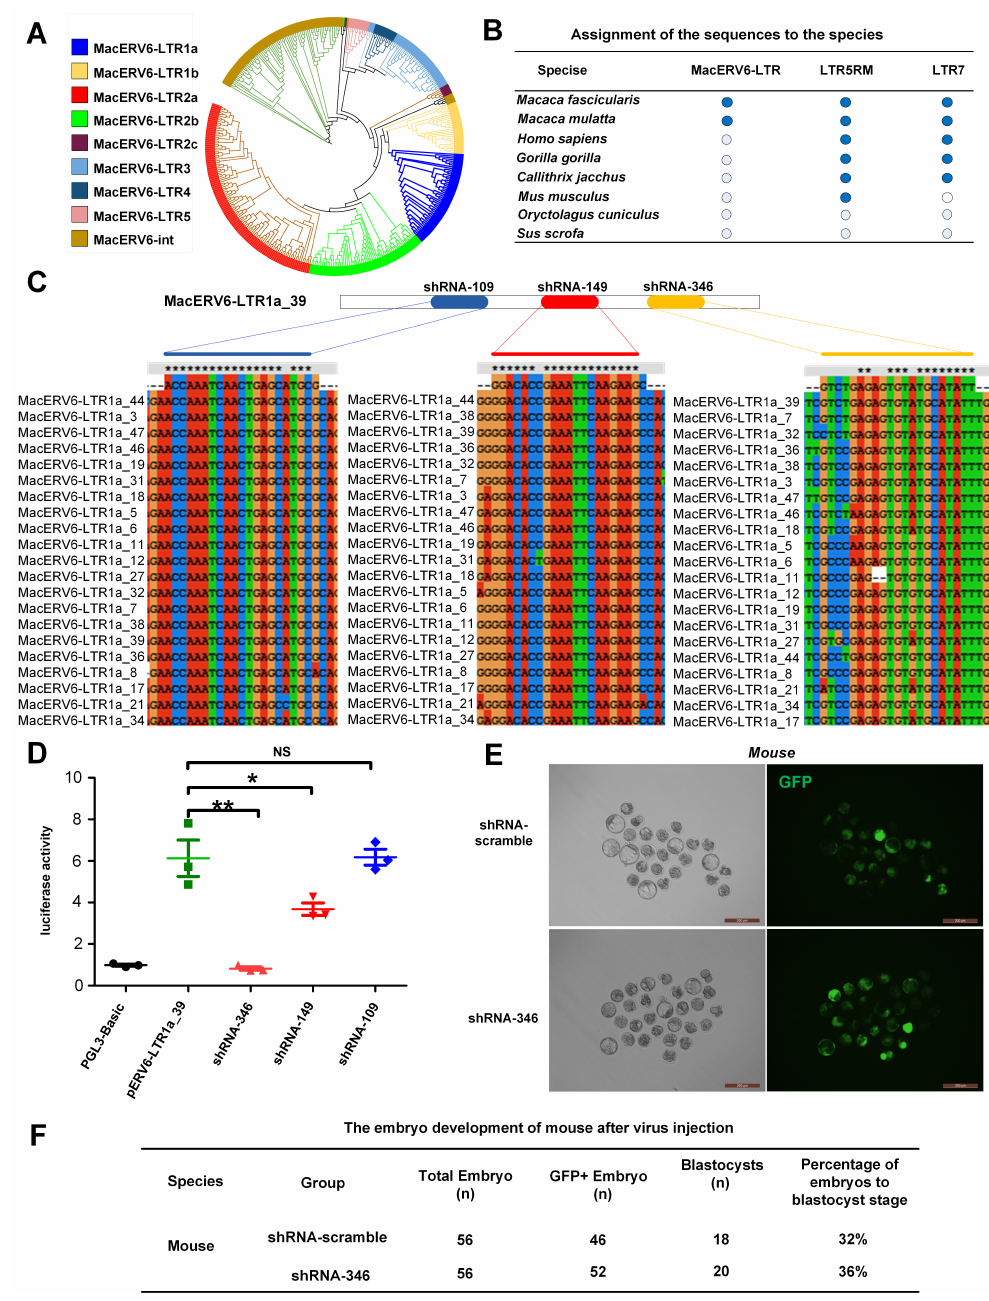
Figure 2. MacERV6-LTR1a knockdown in pre-implantation monkey embryos. ( A ) Phylogenetic tree based on the MacERV6 family sequences. ( B ) The conservation of MacERV6-LTRs, LTR5RM, and LTR7 in selected mammals. The sequences of MacERV6-LTRs, LTR5RM, and LTR7 were aligned to the genomes of different species. Blue circles represent there is the annotated sequence in the genome and white circles are reverse. ( C ) The schematic view of shRNAs, including shRNA-109 (psicoR-EF1A-GFP-shRNA-109), shRNA-149 (psicoR-EF1A-GFP-shRNA-149) and shRNA-346 (psicoR-EF1A-GFP-shRNA- 346), targeting MacERV6-LTR1a_39 sites and the conserved sequences of MacERV6-LTR1a. ( D ) The knockdown efficiency of shRNAs targeting MacERV6-LTR1a. PGL3-basic, control plasmid with no promoter. pERV6-LTR1a_39, luciferase reporter was driven by the MacERV6-LTR1a_39 element. pERV6-LTR1a_39 plasmid was co-transfected with shRNA plasmids (shRNA-346, shRNA-149, shRNA-109) into 293T cells. Data were presented as the mean ± standard deviation (SD), ( n = 3). * p < 0.05, ** p < 0.01. NS, not significant. Student’s t -test. ( E ) GFP signals in mouse embryos that were treated with shRNA-scramble and shRNA-346 lentivirus, separately. Scale bar = 200 µ m. ( F ) The development efficiency of mouse embryo after injection with shRNA-scrambled and shRNA-346 lentivirus